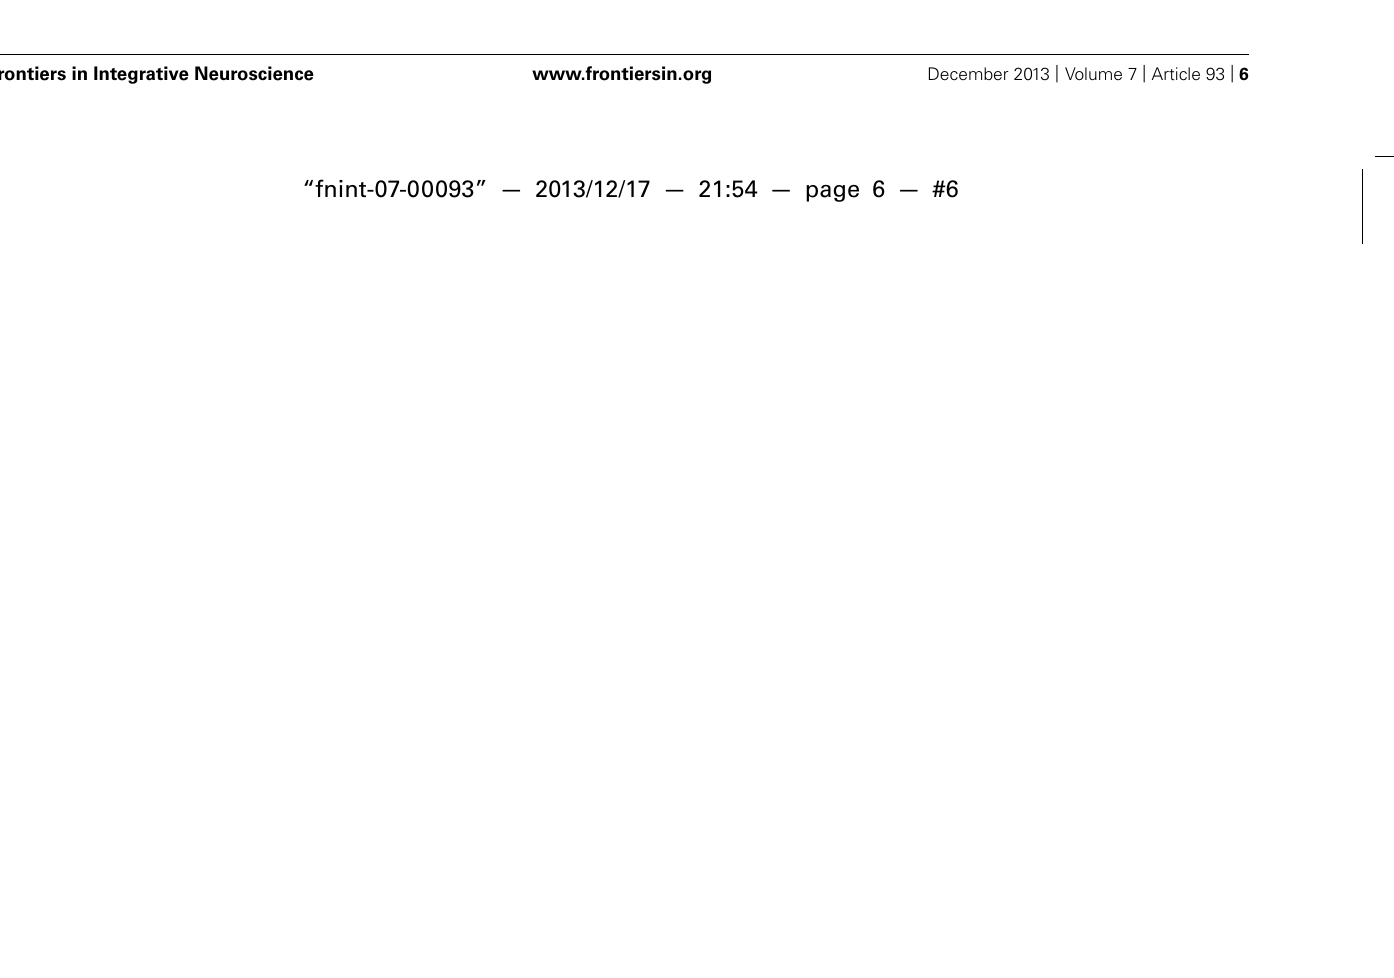
rat VTA DA neuron. (B) Dose–response curves depicting the sex specific stimulating effect of cumulative doses of WIN ( n = 8 for both sexes) on the firing rate of VTA DA neurons in LH rats. Data (mean ± SEM) are expressed as percentages of basal firing rate. * P < 0.05 with respect to pre-drug level (two-way ANOVA followed by Dunnett’s